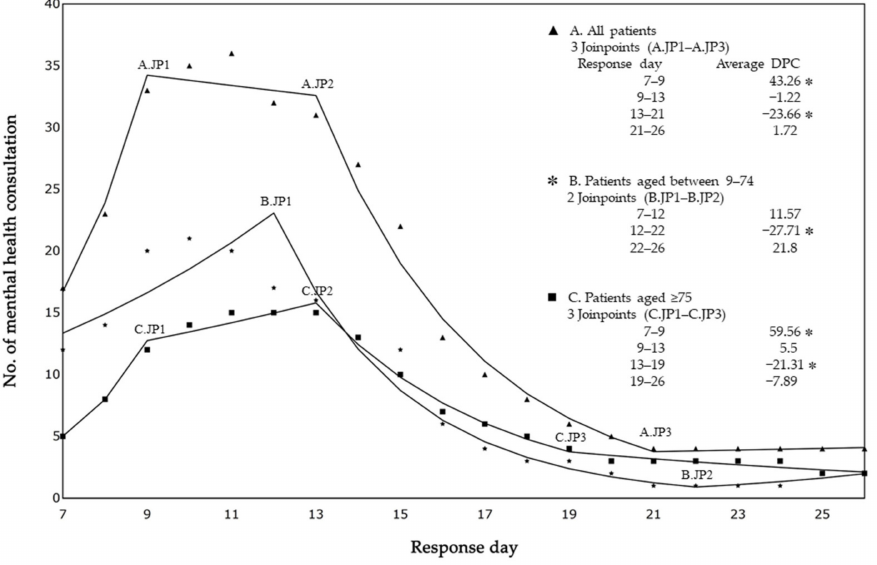
Figure 2. Trends in the number of mental health consultations. JP, joinpoint; DPC, daily percentage change. * Joinpoint regression analysis; p <